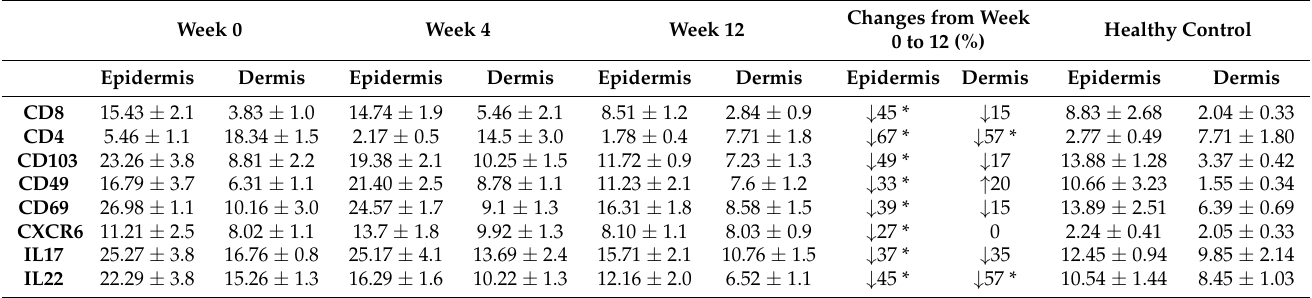
Table 1. Immunoreactive area (%) of TRM markers (X ± SEM) in lesional skin ( n = 10, dermis and epidermis) at week 0, week 4 and week 12 in comparison with healthy control ( n = 10, dermis and epidermis). Asterisks show the statistically significant differences between analyzed groups (week 0 and 12). ↓ —means decrease, ↑ —means increase.